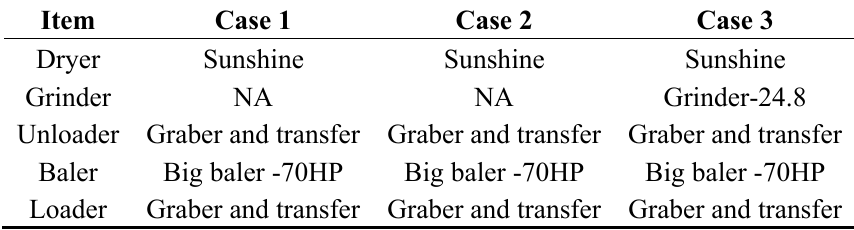
Table A4. Equipment and other elements used in